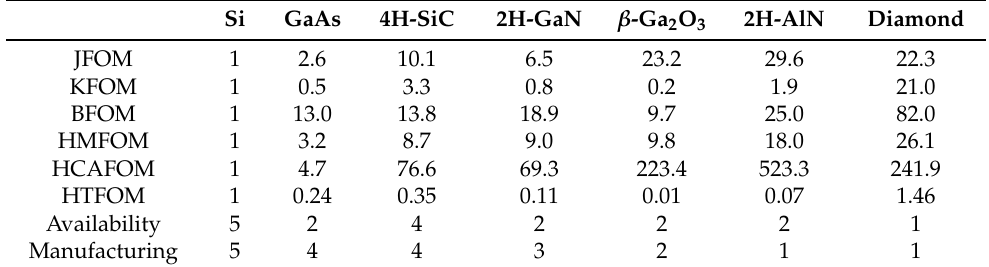
Table 3. Comparison of different semiconductor material figures of merit (normalized against